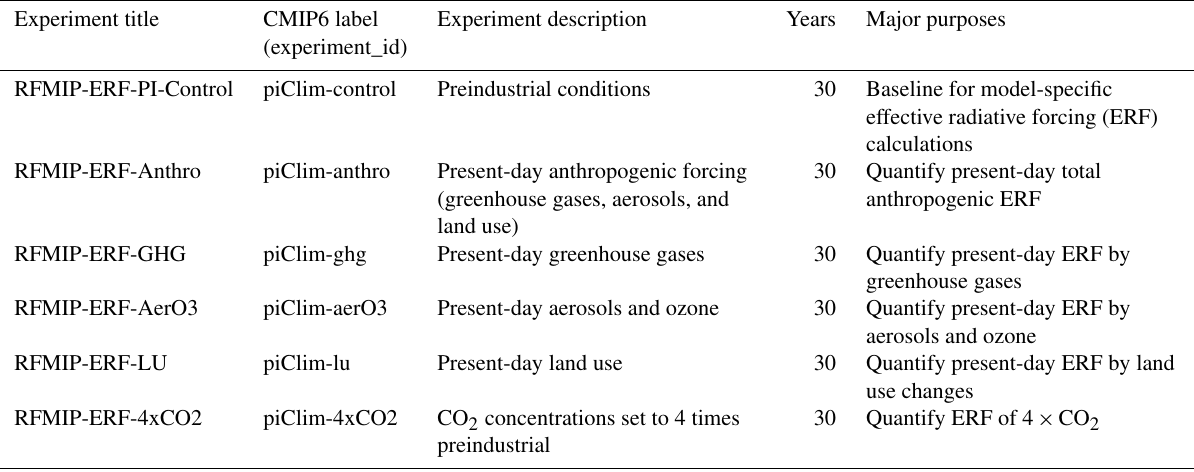
Table 1. Experiments for diagnosing effective radiative forcing at present day and under 4 × CO 2 conditions. These are atmosphere-only integrations with interactive vegetation using sea-surface temperatures and sea ice concentrations fixed at model-specific preindustrial control climatology. All experiments are perturbations to RFMIP-ERF-PI-Cntrl and are requested at Tier 1.